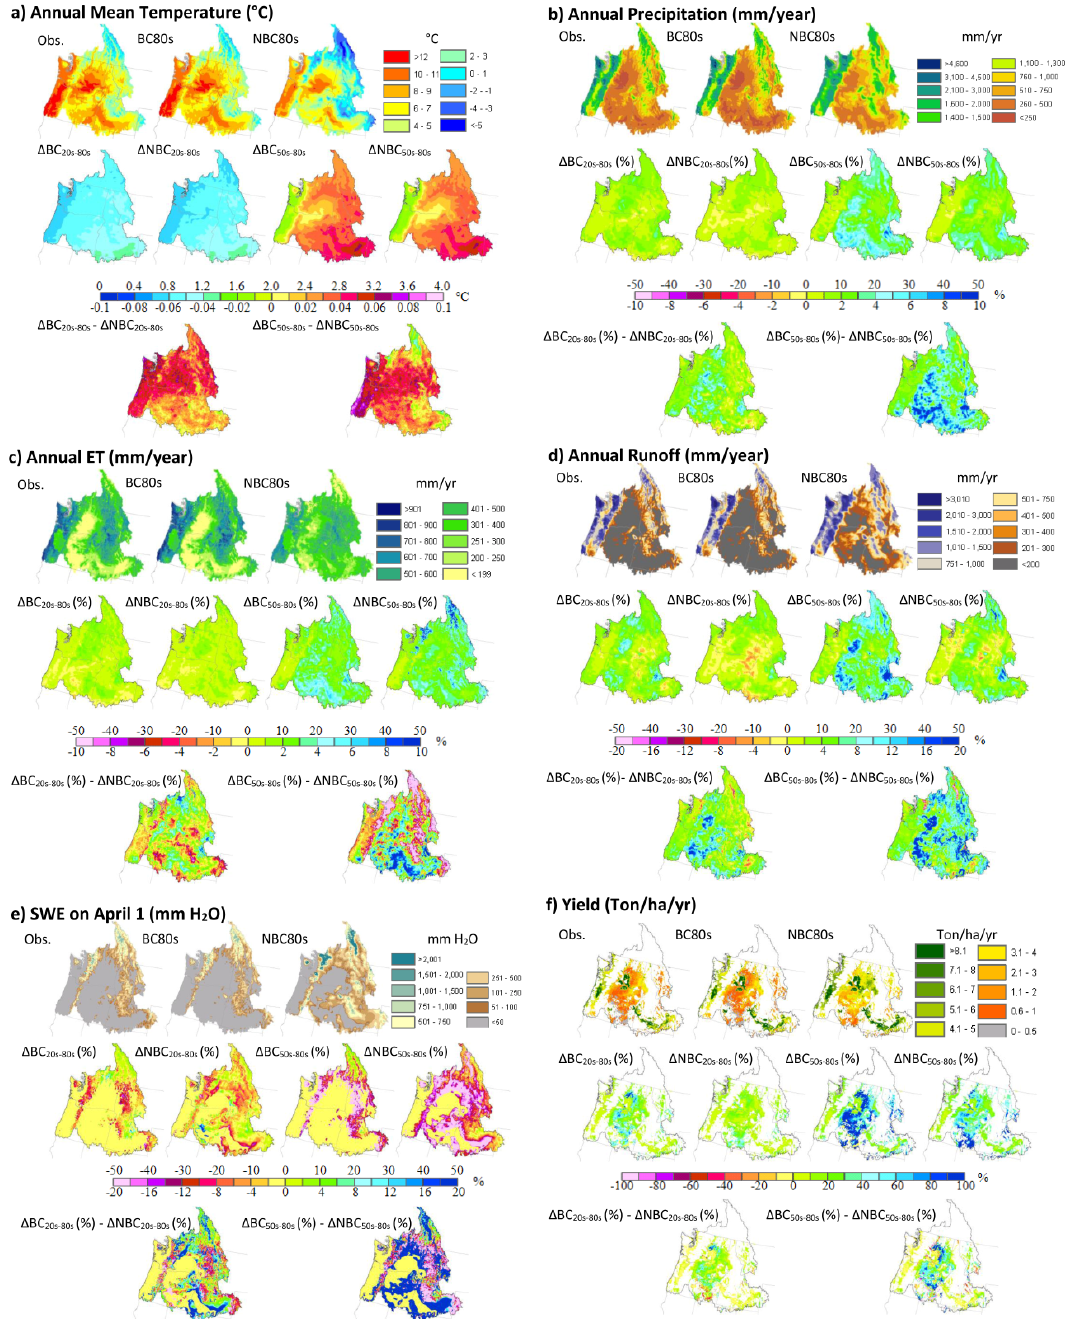
Fig. 5. Spatial patterns of differences in climate and modeled variables driven by observed data (Obs.), bias-corrected (BC), and non-bias- corrected (NBC) climate. 1 BC 20 s − 80 s and 1 BC 50 s − 80 s are total change between the 1980s and 2020s and between the 1980s and